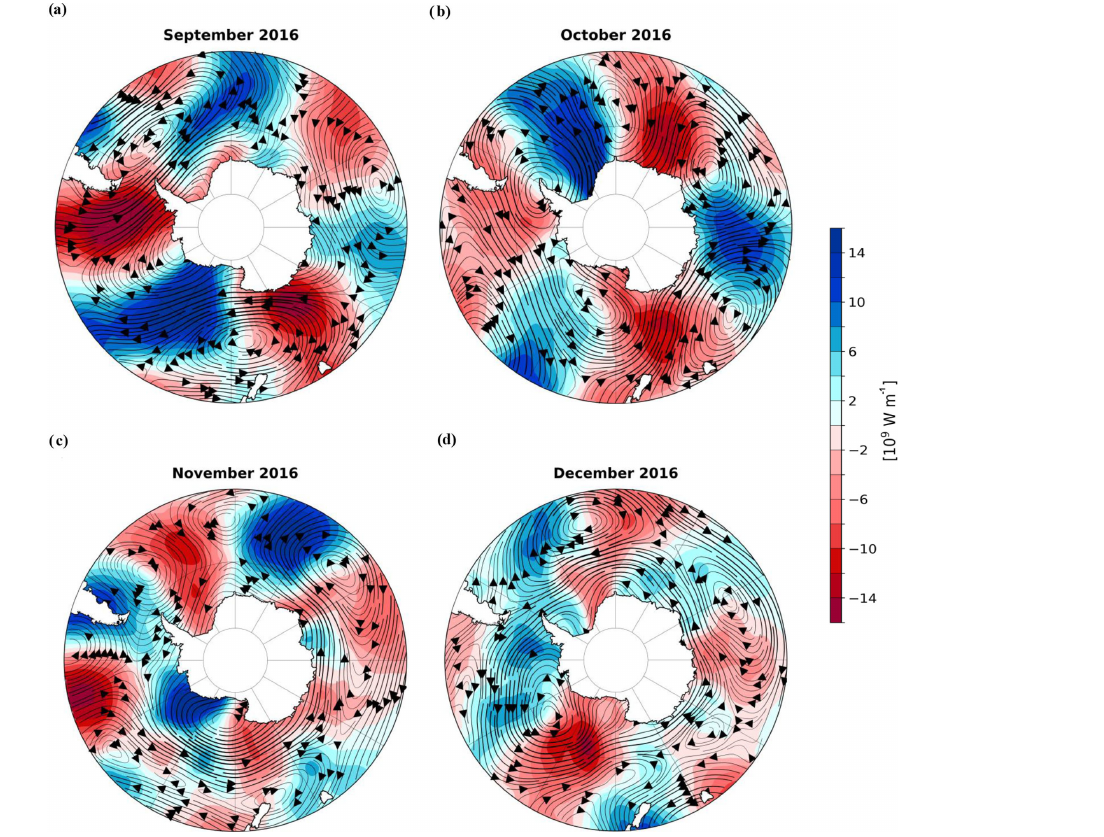
Figure 4. The vertical integral of northward heat flux (shaded areas) and the vertically integrated heat transport (streamlines) (c, d) from September until December 2016. The anomalies are computed relative to the reference period 1979–2010. In (a) – (d) positive anomalies indicate northward advection and negative anomalies indicate southward